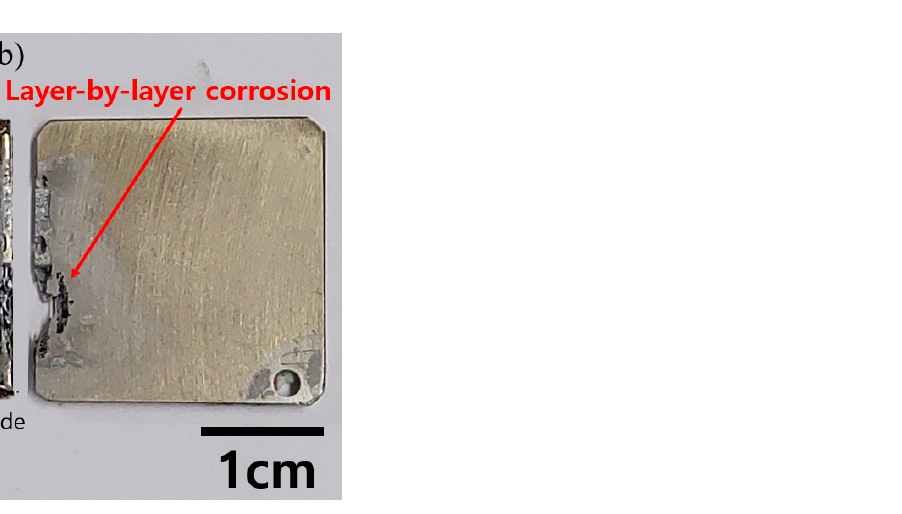
Figure 7. Different shapes of the corroded areas between ( a ) crevice corrosion of SM Ti ‐ 6Al ‐ 4V alloy and ( b ) layer ‐ by ‐ layer corrosion of AM Ti–6Al–4V alloy. 3.3. The Validity of Electrochemical Critical Localized Corrosion Potential in Comparison with Electrochemical Critical Localized Corrosion Temperature The demonstration of the validity of E ‐ CLCP tests of AM Ti alloys was attempted in comparison with E ‐ CLCT tests. The test method for E ‐ CLCT is well described in ISO 22910:2020 [29]. In order to investigate the validity of E ‐ CLCP tests of AM Ni718, AM Ti– 6Al–4V, AM Ti–6Al–7Nb, and AM CP Ti alloys, the E ‐ CLCT test results performed in con ‐ centrated NaCl (25 wt%) aqueous solution were compared with E ‐ CLCP results. The E ‐ CLCP tests were performed in NaCl (3.5 wt%) aqueous solution at 50 °C and in a Ringer solution at 37 °C. Figure 8 shows the correlation of the test results between E ‐ CLCP and E ‐ CLCT, representing the same tendency between E ‐ CLCT and E ‐ CLCP. This tendency in